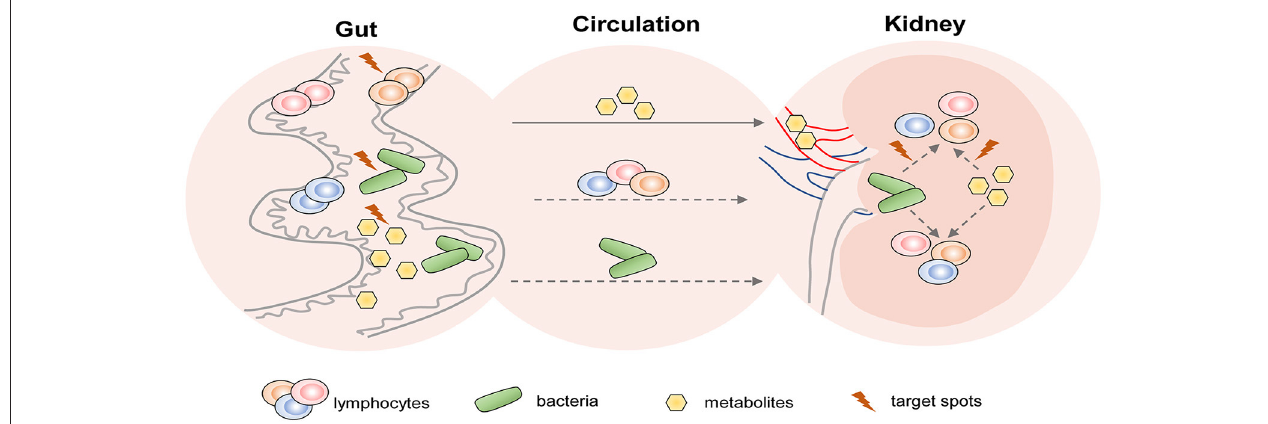
FIGURE 3 | The potential therapeutic strategies targeting T cells of AKI and CKD based on the gut-kidney axis. Based on the theory of “gut-kidney axis,” gut dysbiosis and immune activation induced by kidney diseases including AKI and CKD, in turn, aggravate kidney damage. Thus, there are three aspects of potential therapeutic target spots in the gut to prevent kidney diseases: (1) modulation of gut microbiota; (2) regulation of gut-derived lymphocytes; and (3) alteration of gut-associated metabolites. In addition, gut metabolites and bacteria from circulation may affect lymphocyte-mediated immune responses in the kidney. Therefore, they may also become therapeutic